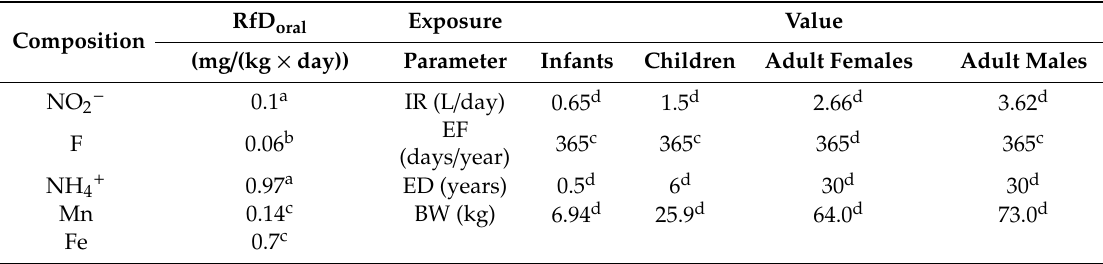
Table 2. RfD and exposure parameters involved in the human health risk assessment.